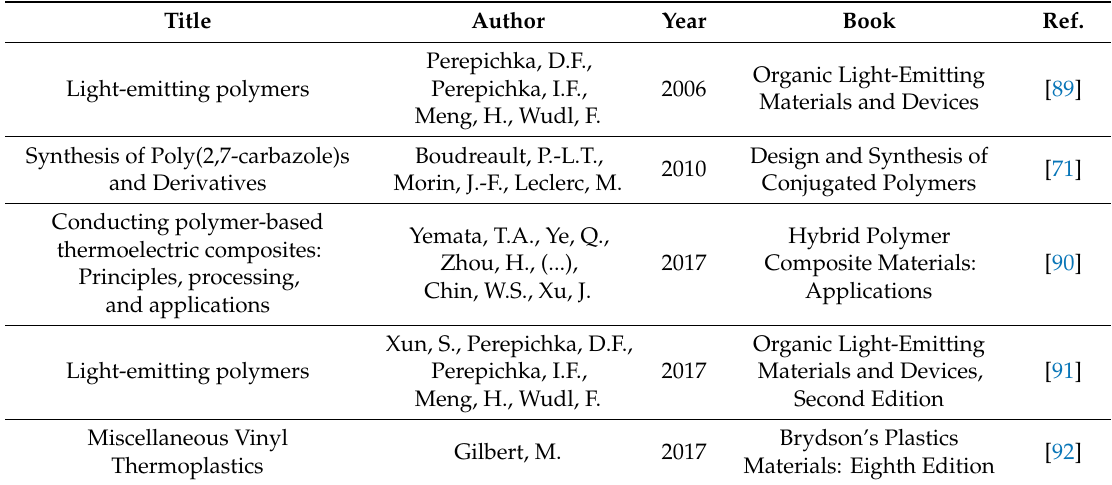
Table 2. Summary of the book chapters on poly(carbazole)derivatives extracted from